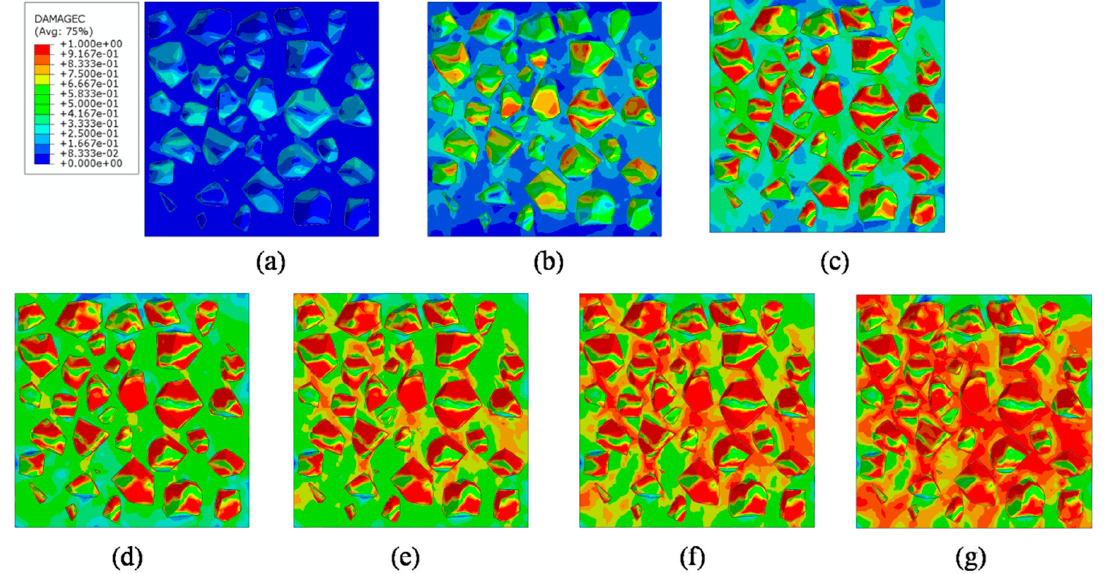
Figure 29. Section patterns of compressive damage initiation and evolution under compression.